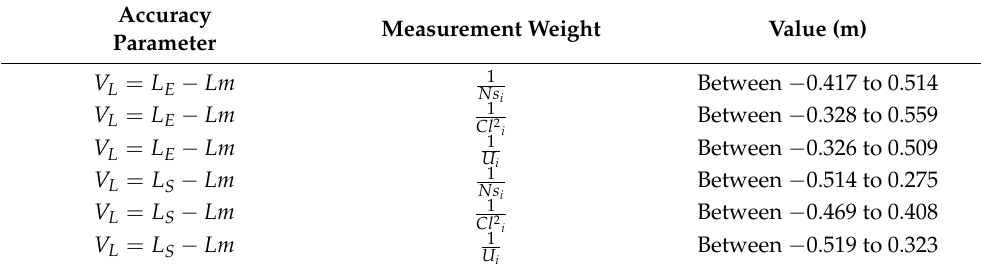
Table 3. The residuals along the L